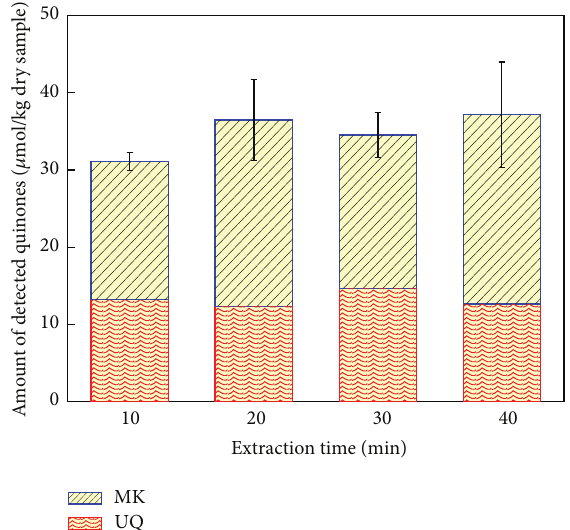
Figure3:Detectedamountofquinonesobtainedindifferentextrac- tiontimeperiods.Sample:0.3 gdrycompostoffoodwasteandwood chips. SFE conditions: 25 MPa; 90% CO 2 -10% methanol; flow rate of 3 mLmin −1 ; 45 ∘ C; number of samples examined = 3.